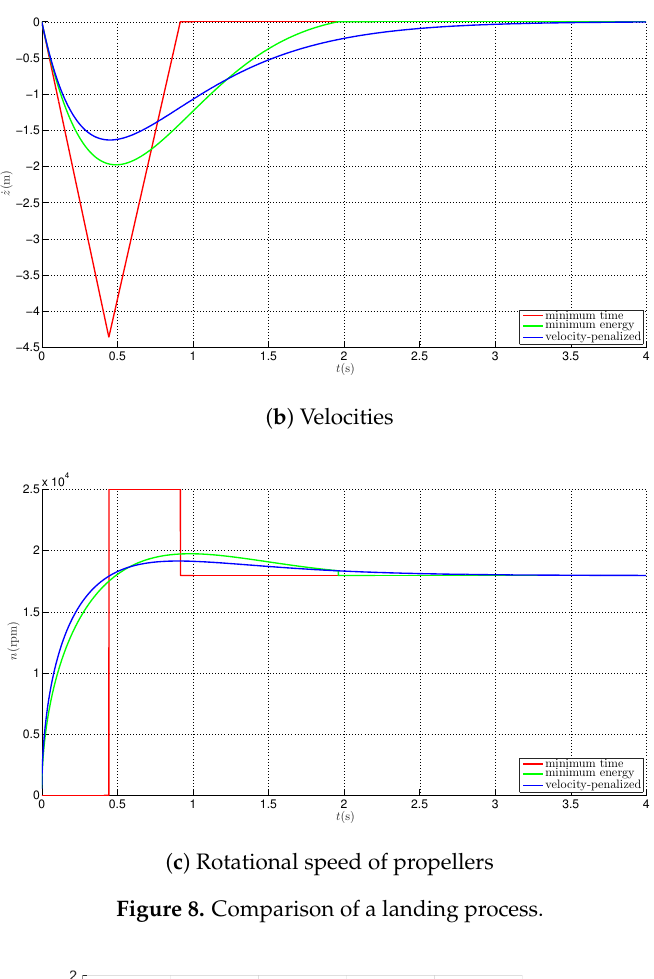
Figure 8. Comparison of a landing process.